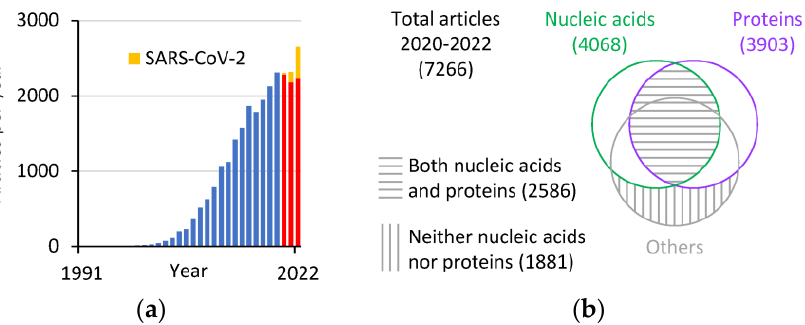
Figure 1. Bibliometric analysis of articles featuring AuNP-based biosensors (data from Scopus). ( a ) Articles per year that have “gold nanoparticle biosensor” or “detection” in the title, abstract, or keywords, excluding the words “lateral flow”, and limited to the “article” document type. The red bars refer to the years 2020–2022 characterized by the COVID-19 pandemic, with the yellow portion of the bars representing the articles mentioning “SARS-CoV-2” in the title, abstract, or keywords. ( b ) Venn diagram of the 2020–2022 articles from panel a grouped based on the presence or absence of the words DNA or RNA (nucleic acids) and protein in the title, abstract, or keywords.